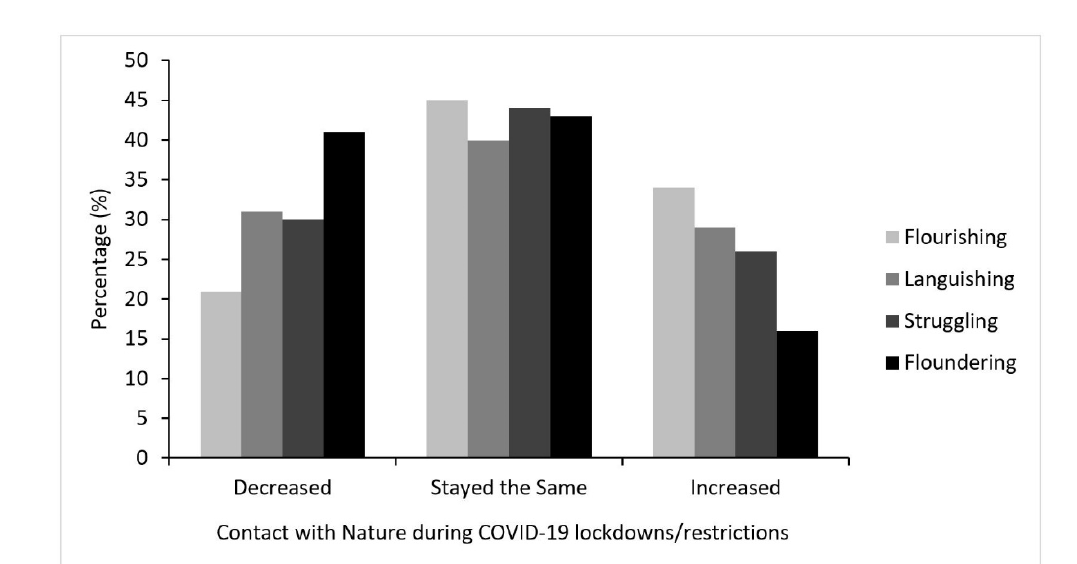
Table 6. Associations between purposive nature contact/experiences and mental health state during COVID-19 lock- downs/restrictions. Variables Languishing vs. Flourishing Struggling vs. Flourishing